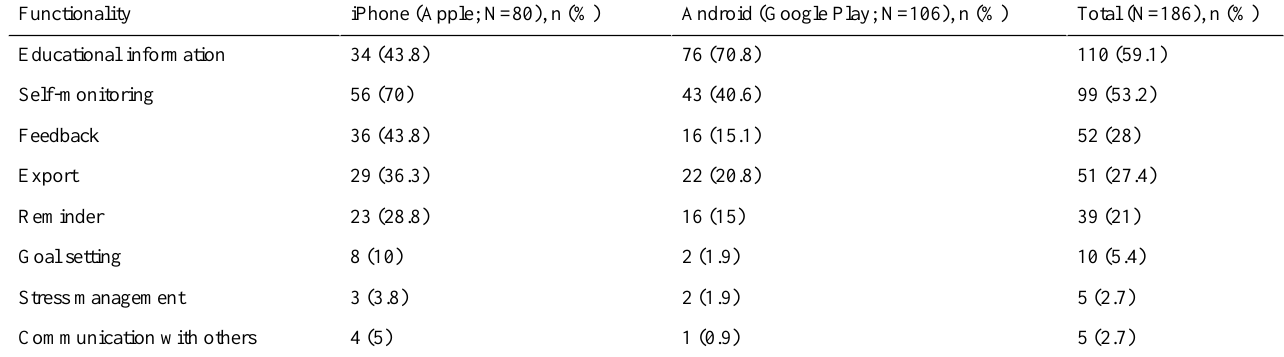
Table 1. Frequency of app